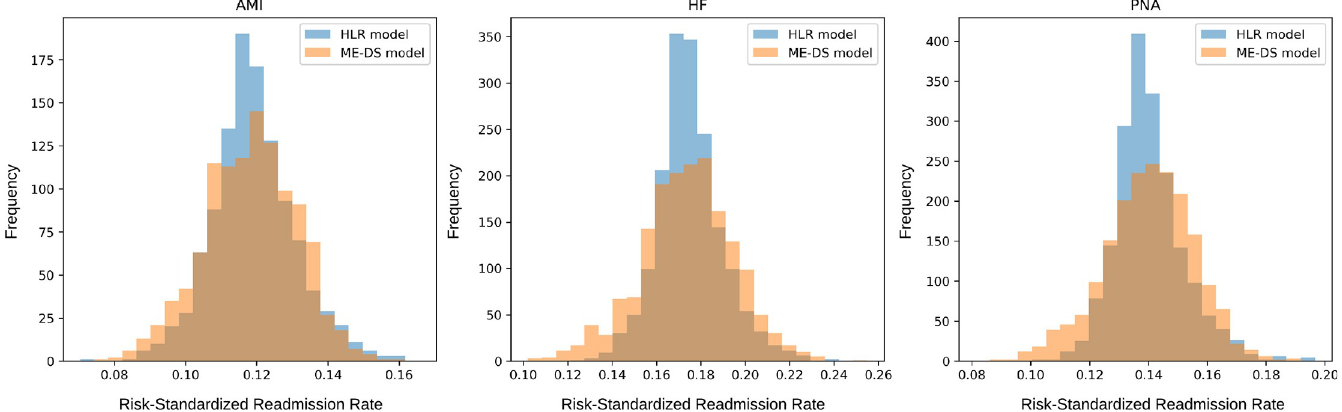
Fig 1. Distribution of risk-standardized hospital readmission rates. This figure shows differences in the distribution of risk-standardized hospital readmission rates for acute myocardial infarction (AMI), congestive health failure (HF), and pneumonia (PNA) generated by the hierarchical logistic regression (HLR) model and the medical code embedding Deep Set architecture ANN (ME-DS) model. Standardized readmission rates are generated by comparing model predictions to expected readmission rates for each hospital. This figure illustrates that despite having comparable predictive accuracy LHR and MS-DS lead to differences in hospital risk stratification.